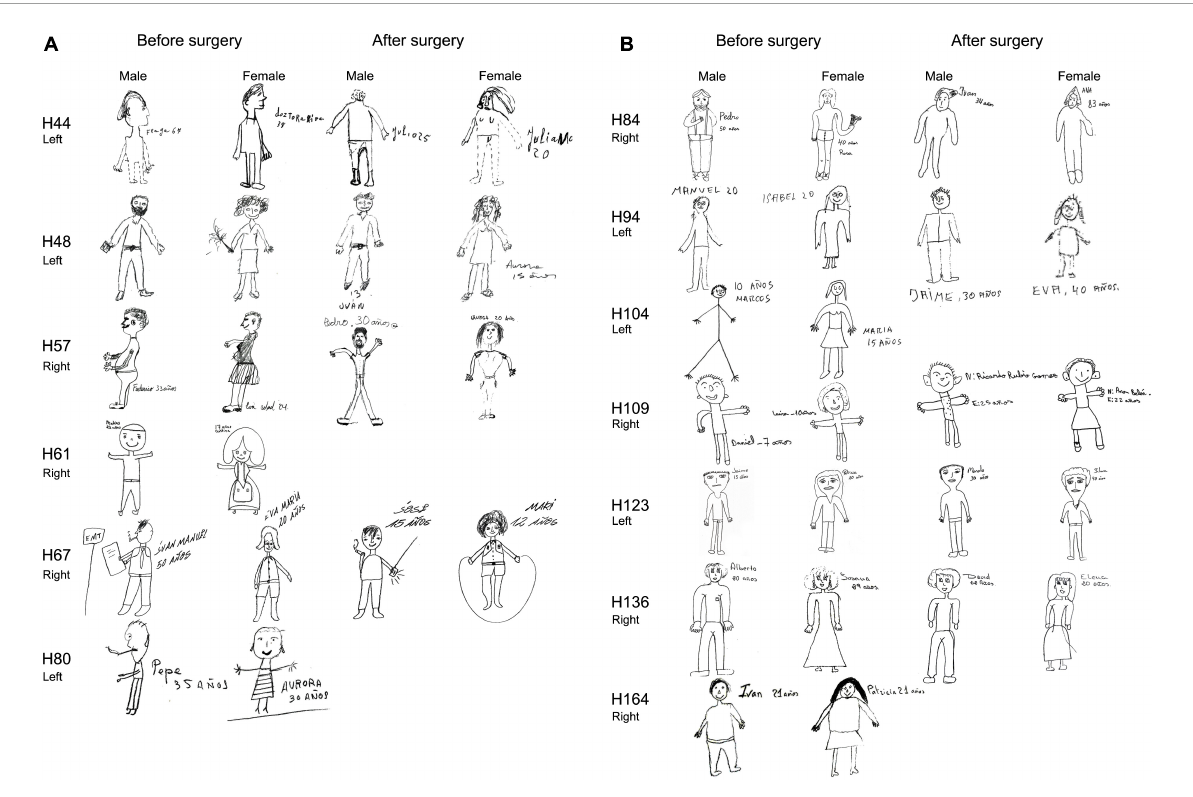
FIGURE10 (A) Person (male, female) drawings of the H-T-P test (before and after surgery) performed by HS-patients rendered seizure-free after surgery. Patients were asked to draw both genders. All patients except H44 and H61 were right-handed. Patients H61 and H80 were not evaluated after surgery. Note dashed lines (H44, male before surgery and female after surgery) and transparencies (H44, female after surgery; H57, female before surgery). The size of the original drawings was not considered. (B) Person (male, female) drawings of the H-T-P test (before and after surgery) performed by HS-patients rendered seizure-free after surgery. Patients were asked to draw both genders. All patients were right-handed. Patients H104 and H164 were not evaluated after surgery. Note simplicity but not significant changes after surgery. The size of the original drawings was not